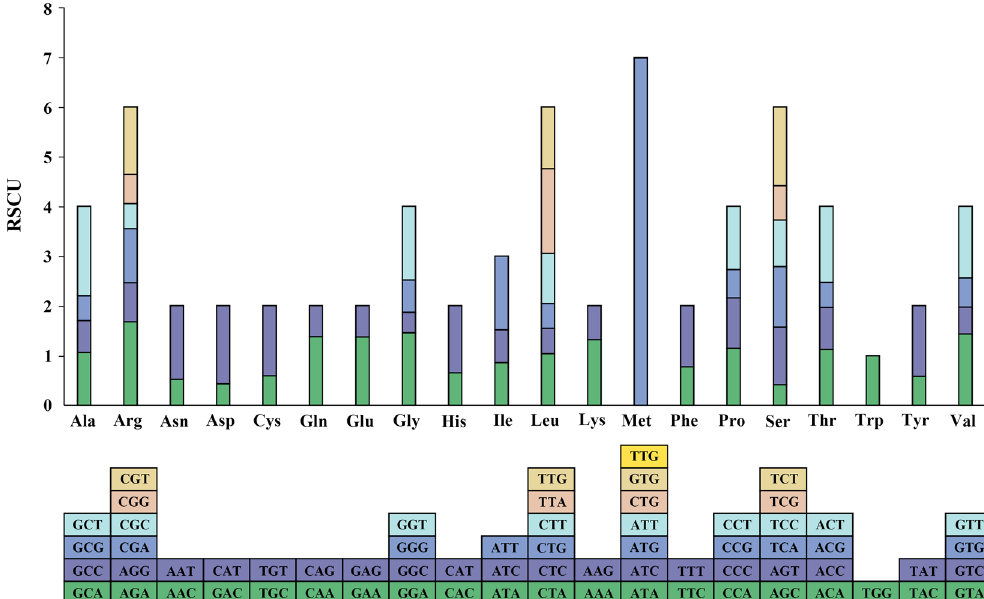
Figure 2. Relative synonymous codon usage of S. lepifera . The bottom square represents all codons encoding each amino acid, and the height of the upper column represents the sum of RSCU values of all